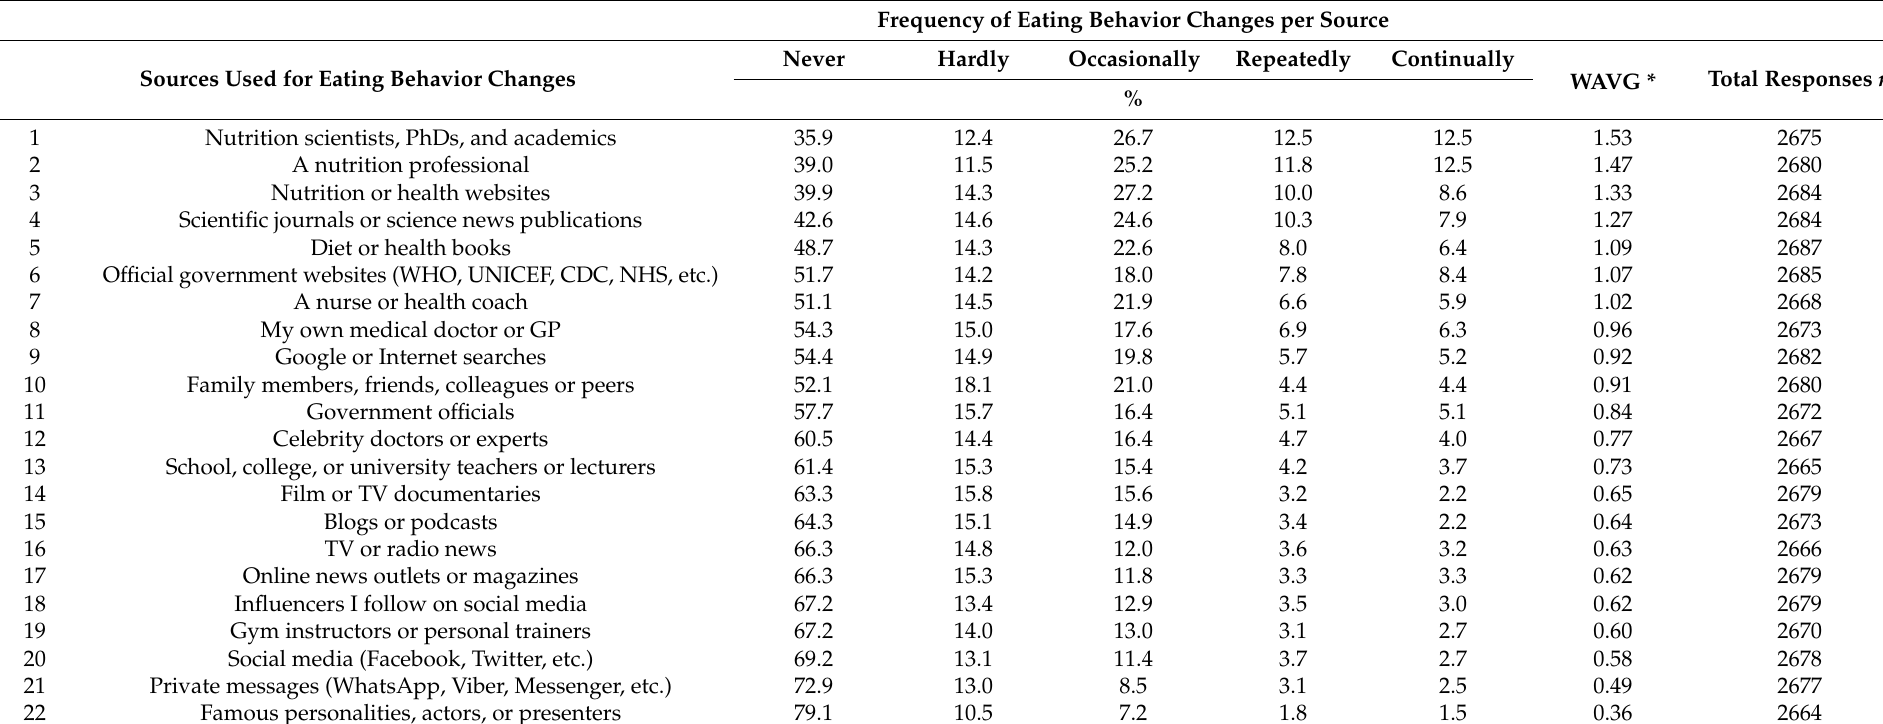
Table 2. Self-reported frequency of eating behavior change based on different sources of information during the early stages of the global COVID-19